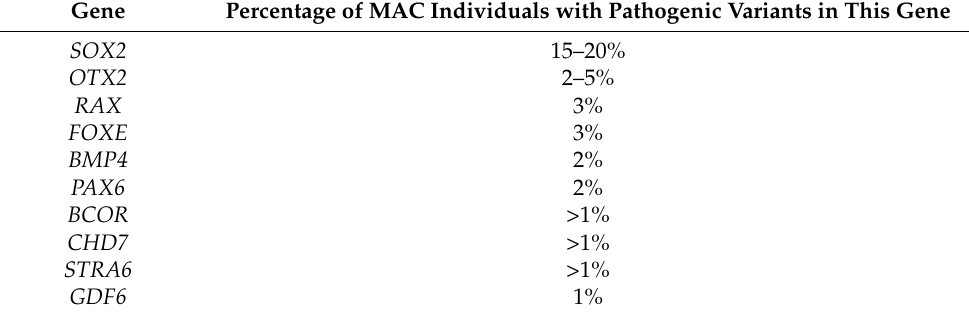
Table 1. Pathogenic variants frequently associated with MAC spectrum [8].